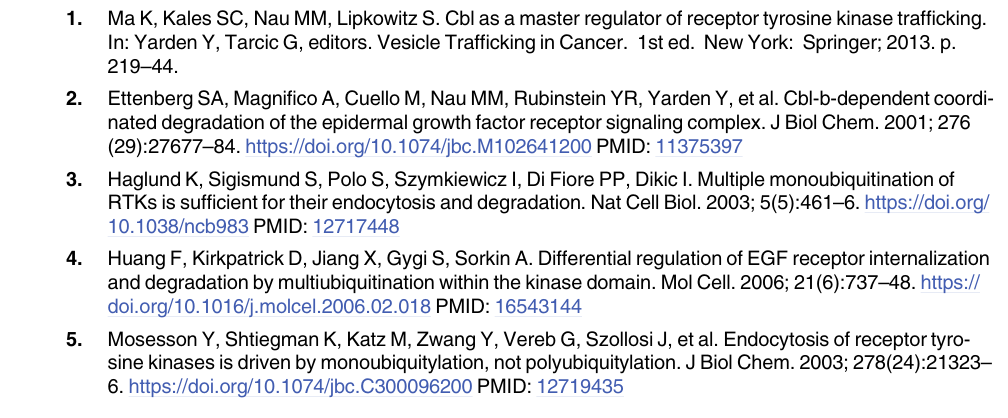
S1 Table. Cbl mutations by tumor type in TCGA. (PDF) S2 Table. Cbl-b mutations by tumor type in